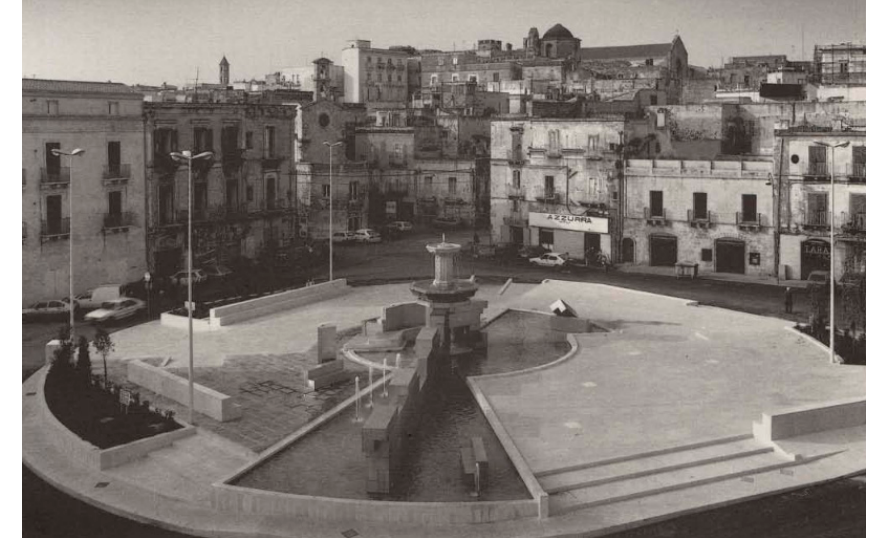
Figure 9. View of Piazza Fontana at the end of the work in the early 1990s